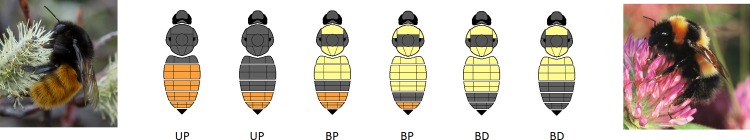
Colour Patterns of the Subgenus Alpinobombus.Simplified diagrams [26] representing the principal variation in colour patterns of the hair on the female dorsum coded as two two-state characters: UP, unbanded pale tail; BP, banded pale tail; BD, banded dark tail; with hair colours: yellow, yellow or yellow-brown hair; orange, orange-red or white hair; dark grey, black hair. Only female patterns are shown because females make up the majority of samples for social bumblebees, although male patterns are similar. Photos show: (left) B. alpinus and (right) B. hyperboreus. Photos by (left) A. Staverløkk and (right) G. Holmström.